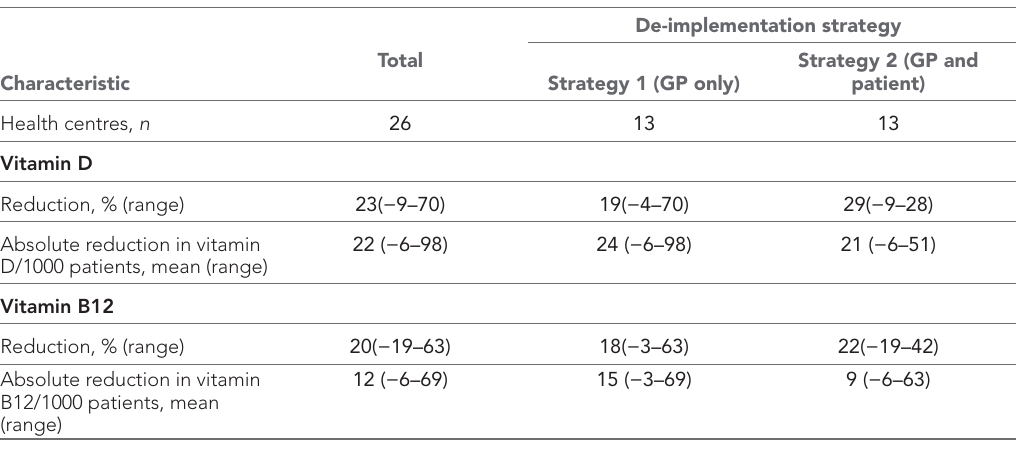
Table 2 Reduction in number of vitamin D and B12